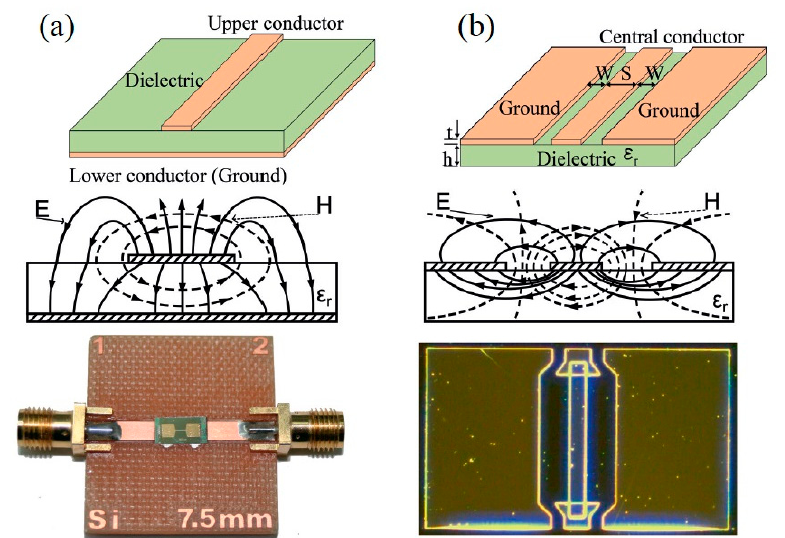
Figure 4. MI measurement circuits based on transmission lines. ( a ) Microstrip line where conductor is at the top and ground at bottom. ( b ) Coplanar line where the conductor and ground are on the top surface. Reprinted with permission from [9] , under the Creative Commons Attribution (CC BY 3.0) license.